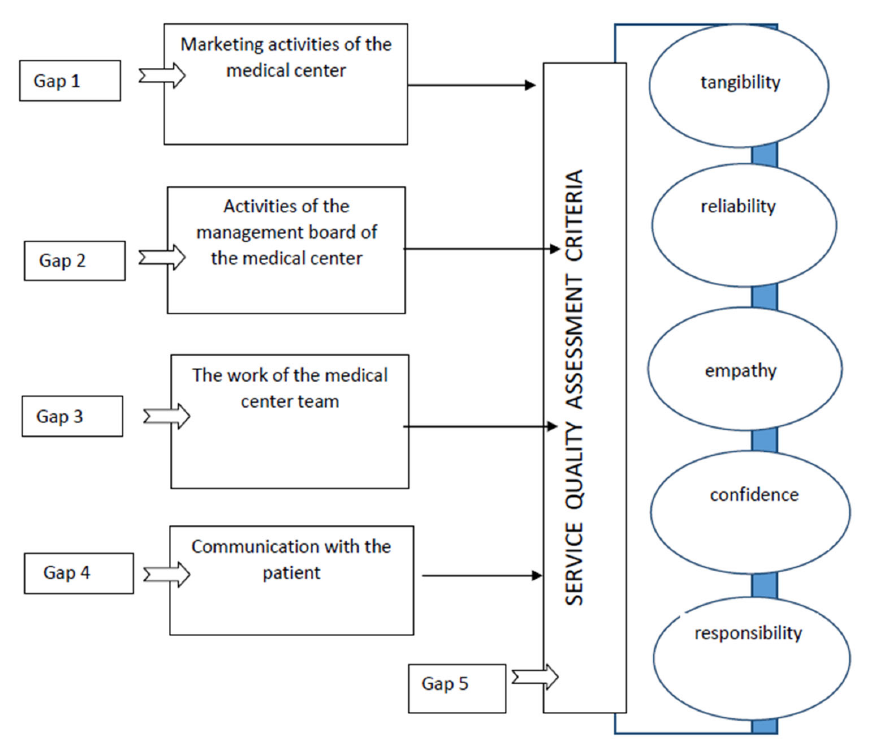
Figure 1. Quality gap model, on the basis of Parasuraman A. et al. “A Conceptual Model of Service Quality and Its Implications for Future Research” [4], used with the permission of the publisher of the original article.